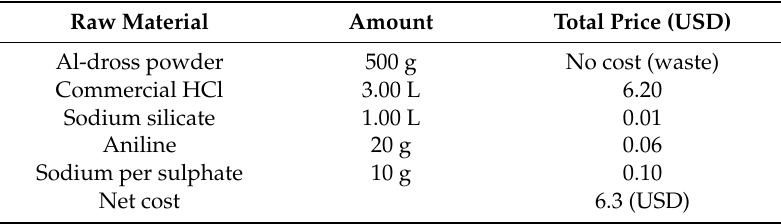
Table 4. Cost estimation per kg of the adsorbent (SBDP